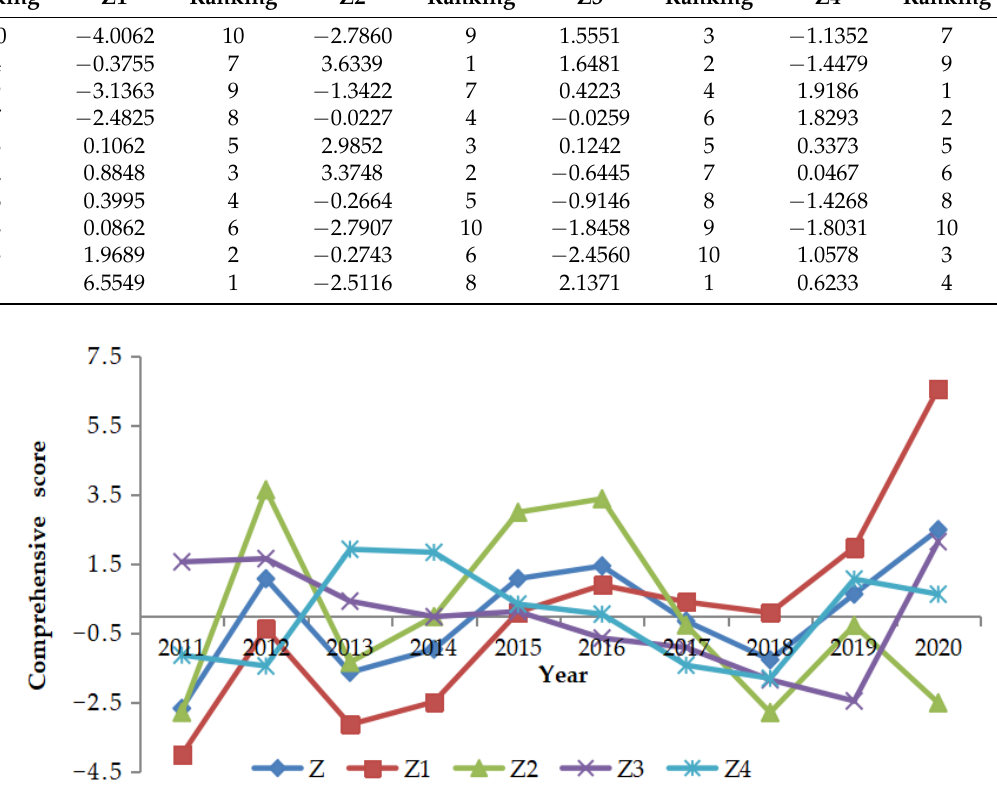
Figure 2. Comprehensive score of water ecological civilization in Jiangxi Province.